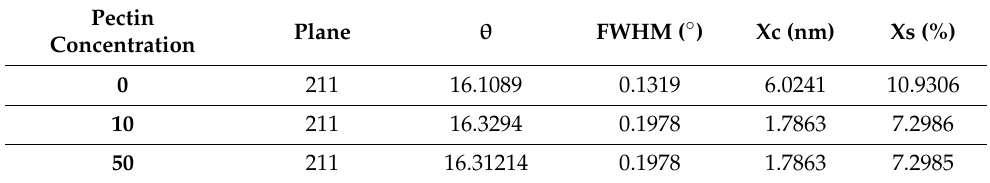
Table 2. Crystallinity and crystallite size of the synthesized HAp/pectin composite. Pectin Concentration